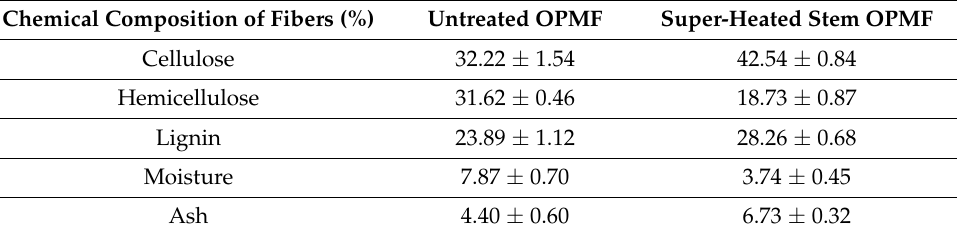
Table 7. Chemical compositions of untreated and treated